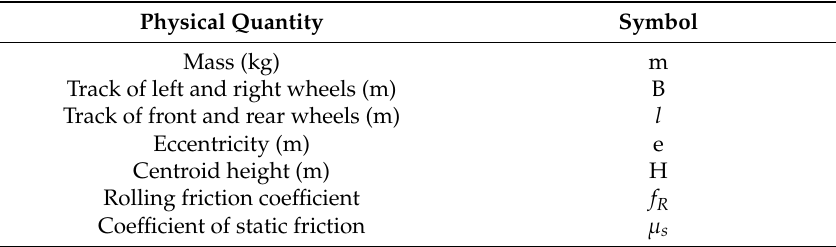
Figure 3. AGV simplified model. Table 1. AGV structure physical quantities.